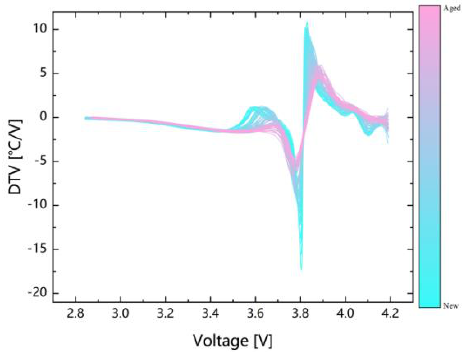
Figure 4. Aging Evolution of DTV curves.